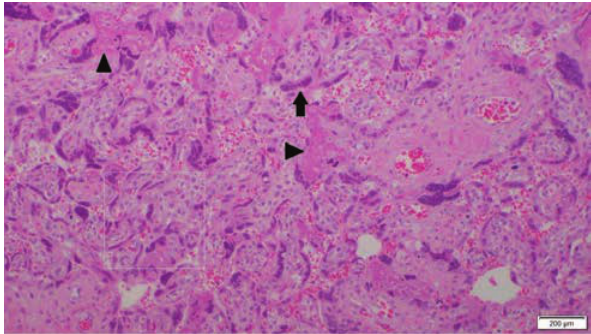
Figure 1: Histopathology of the placenta. A photomicrograph showing areas with accelerated maturation-increased perivillous fibrin deposition (arrowheads), increased amount syncytial knots (arrow) and agglutinated villi (square). These pathological changes are characteristic for maternal vascular malperfusion. Hematoxylin and eosin staining